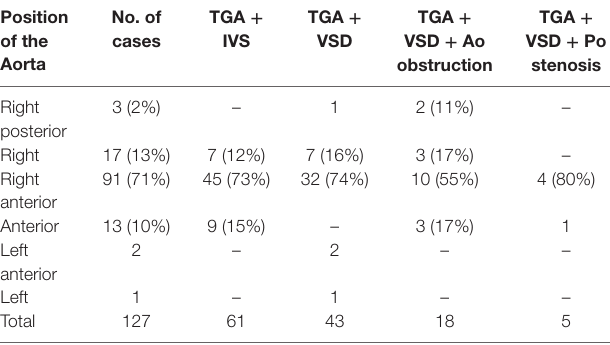
TaBle 3 | complete Tga: relation of the great